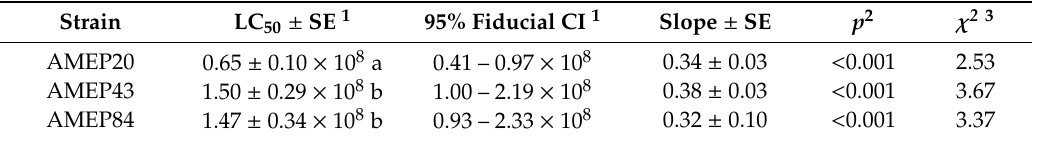
Table 3. Summary of probit analysis parameters from the virulence bioassays performed with the most pathogenic Beauveria strains against Hylobius abietis adults in laboratory.